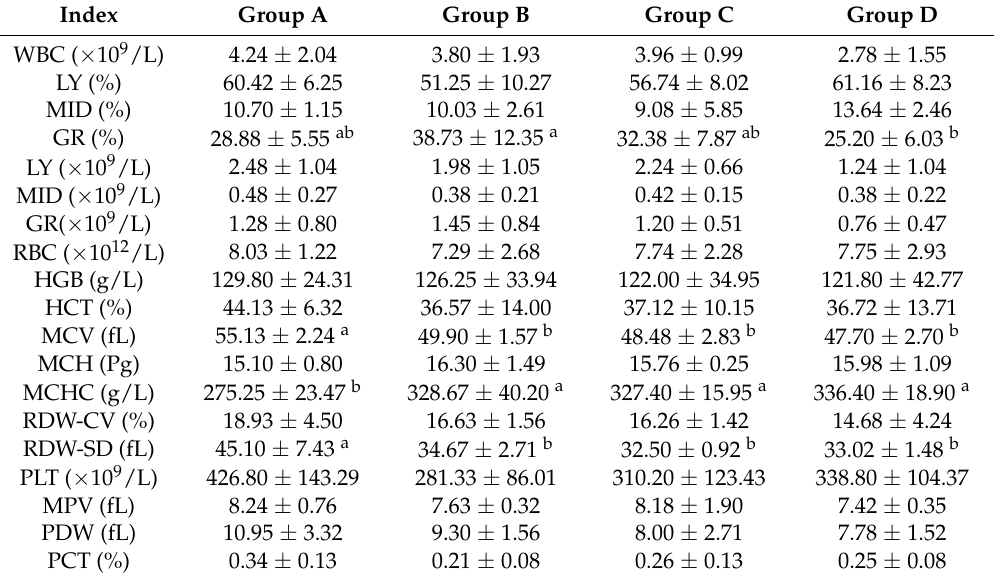
Table 2. Effect of intragastric administration with C. butyricum Sx-01, L. salivarius C-1-3 and a combination thereof on blood indices of